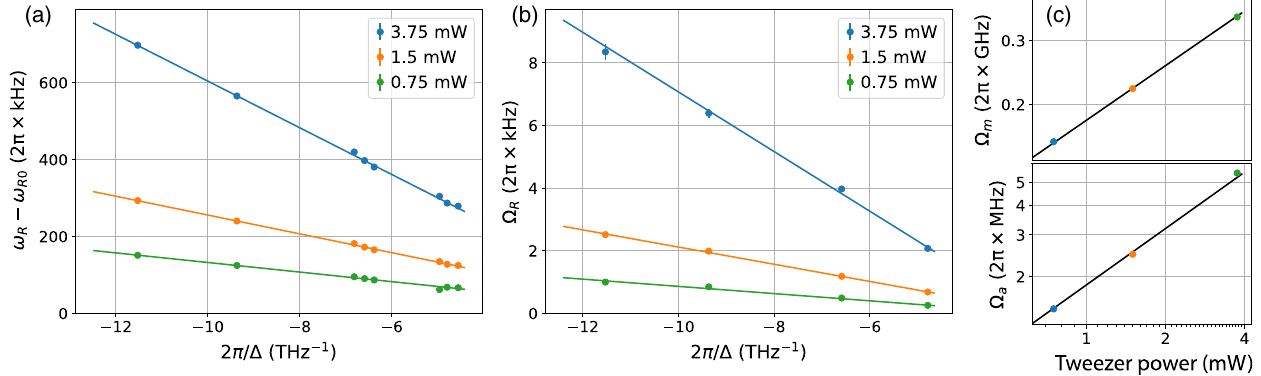
FIG. 4. Raman transition parameters as a function of tweezer power and detuning. (a) The Raman resonance ω R fitted to a P þ b P = Δ , where a P and b P ¼ ð Ω 2 a − Ω 2 m Þ = 2 are the power ( P ) dependent background and v 0 ¼ 0 contributions to the light shift and Δ ≡ 2 π × ð f − f Þ is the detuning from the v 0 ¼ 0 resonance frequency f . a P is fitted to a model including linear and small quadratic PA 0 tweezer PA 0 light shift to obtain the Raman resonance frequency at zero tweezer power ω R 0 ¼ 2 π × 770 . 1969 ð 2 Þ MHz, where the statistical uncertainty is shown. (b) Raman Rabi frequency Ω R fitted to c P þ d P = Δ , where c P and d P ¼ Ω a Ω m = 2 are the background and v 0 ¼ 0 fitted in (a). Fit parameters are listed in Table I. (c) Tweezer power contributions that scale as P 1 . 29 . The detuning is calculated from f PA 0 dependency of Ω m (top) and Ω a (bottom) calculated from b P and d P on a log-log scale showing approximate P 0 . 5 scaling of Ω m and P 0 . 79 scaling of Ω a